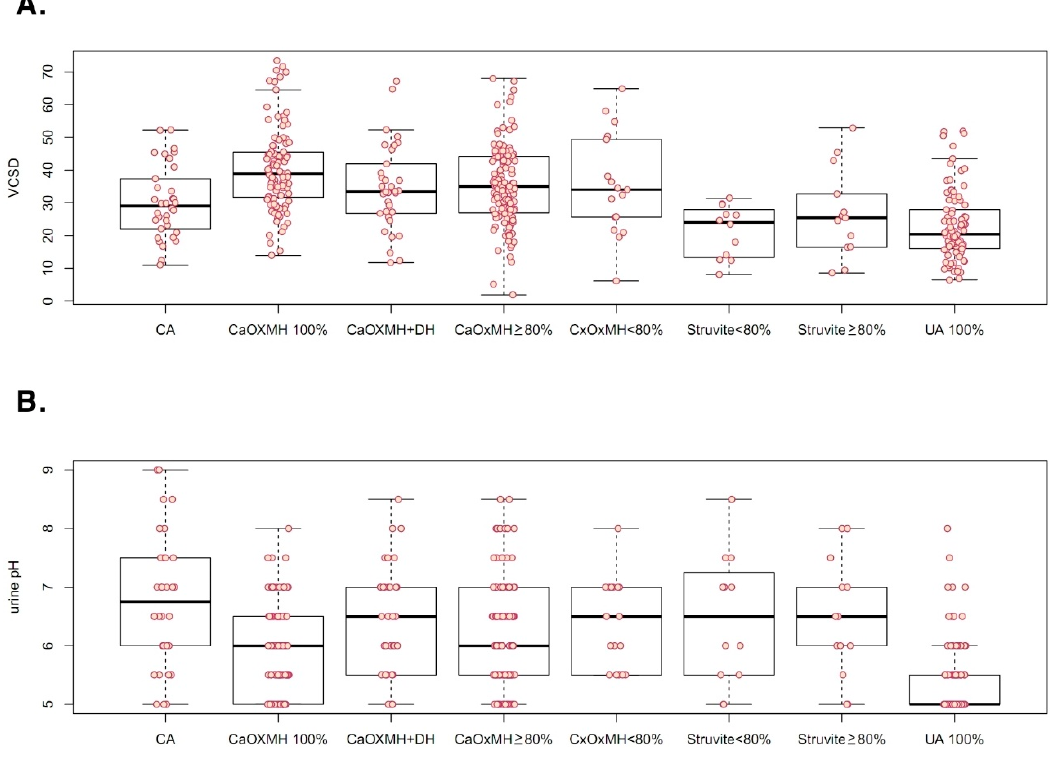
Figure 2. Variant coefficient of stone density (VCSD; determined via non-contrast computed tomography) ( A ) and urinary pH ( B ), shown by stone composition. CA: carbonate apatite; CaOx: calcium oxalate; MH: monohydrate; DH: dihydrate; UA: uric acid.